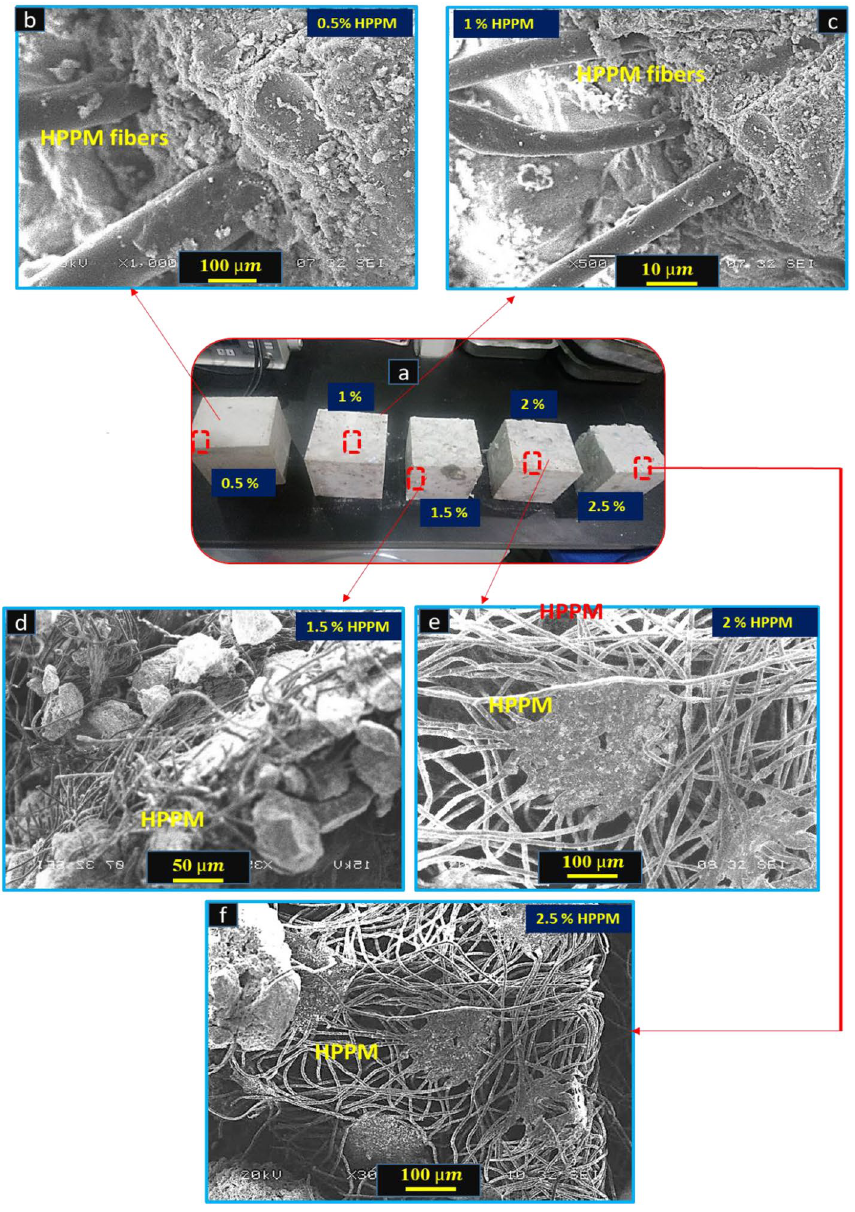
Figure 14. SEM images of concrete with HPPM fibers. ( a ) Cubes with different percentages of HPPM, ( b – f ) 0.5, 1, 1.5, 2 and 2.5% of HPPM